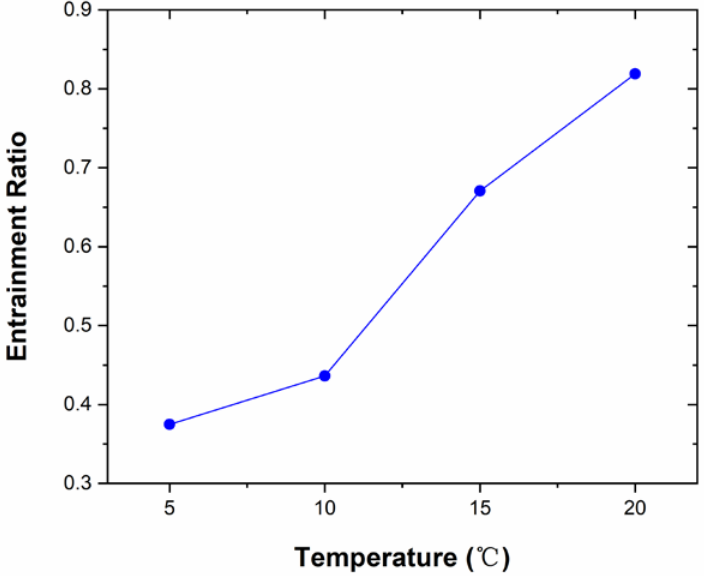
Figure 13. The variation of the entrainment ratio with different secondary fluid temperature.